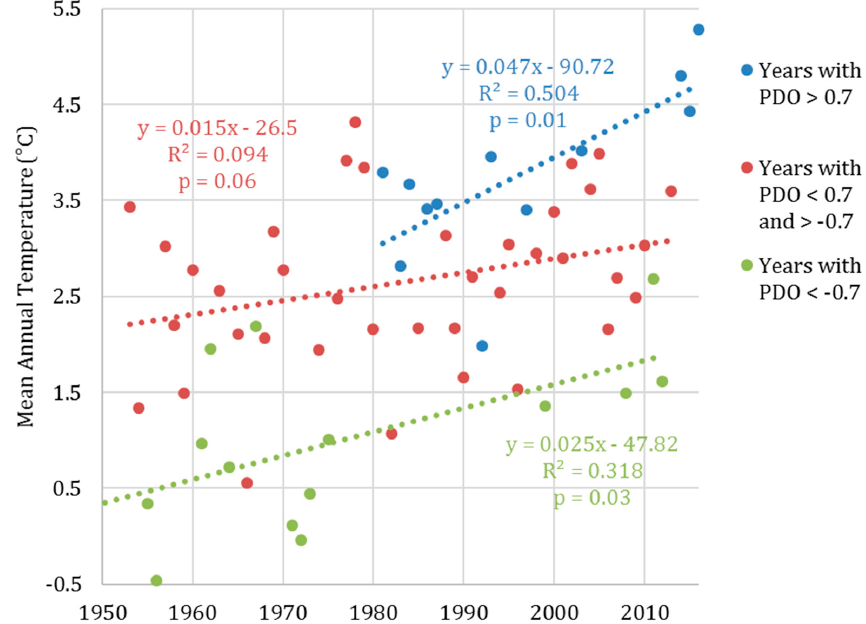
Figure 8. Mean annual temperature of Anchorage (1949–2016) as a function of different classes of the PDO values. PDO